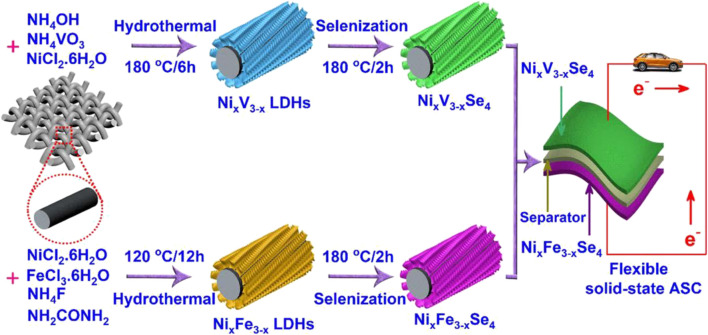
Schematic representation for the design and fabrication of hierarchical NixV3−xSe4 and NixFe3−xSe4 nanostructures for solid-state ASCs.